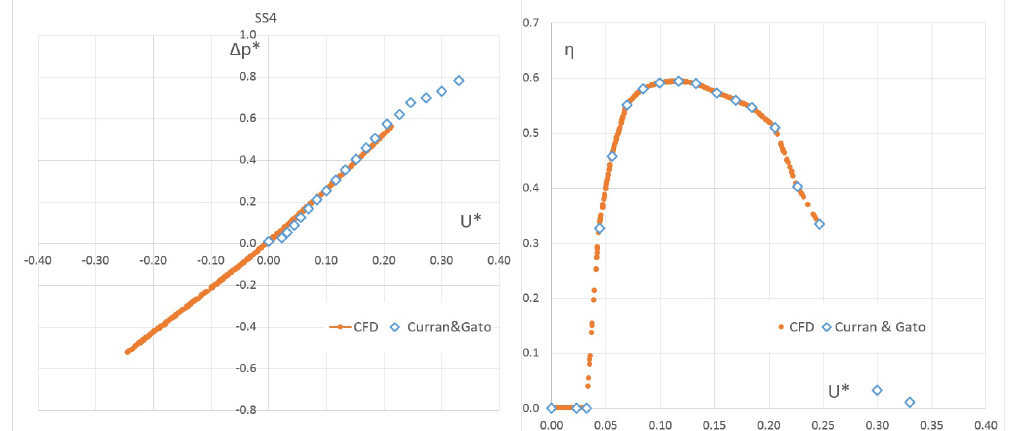
Figure 18. Equivalent characteristic curves of the Wells turbine (SS4).